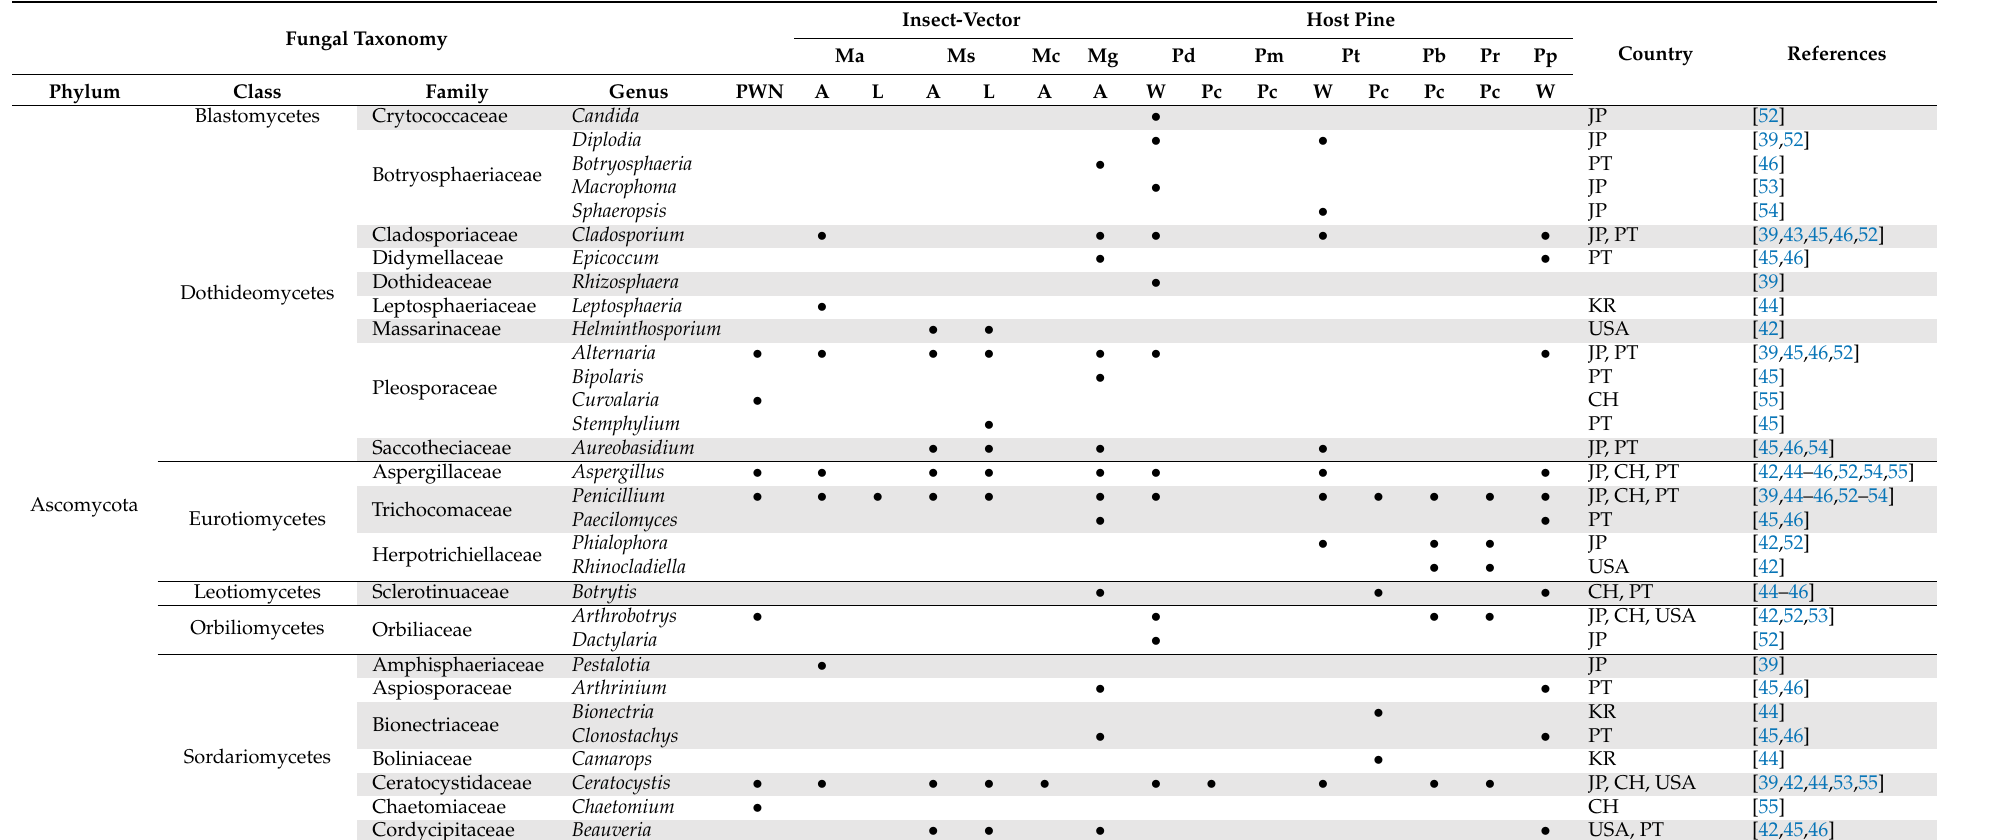
Table 1. Culture-dependent mycoflora isolated from the PWN, insect-vectors, and host pines. PWN, Bursaphelenchus xylophilus ; Ma, Monochamus alternatus ; Ms, M. scutellatus ; Mg, M. galloprovincialis (A—Adult, L—Larvae); Pd, Pinus densiflora ; Pm, P. massoniana ; Pt, P. thunbergii ; Pb, P. banksiana ; Pr, P. resinosa ; Pp, P. pinaster (W—wood, Pc, pupal chamber); JP, Japan; PT, Portugal; KR, Korea; CH, China; USA, United States of